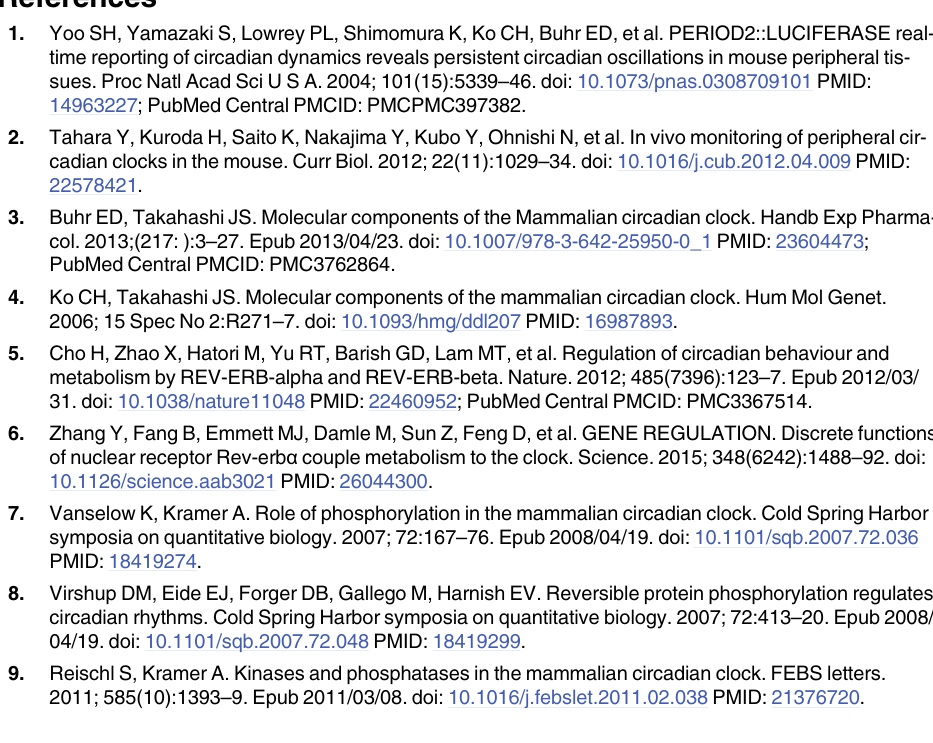
in μ mol/g wet liver. Glucose coming from glycogen was determined as (total glucose)-(free glu-